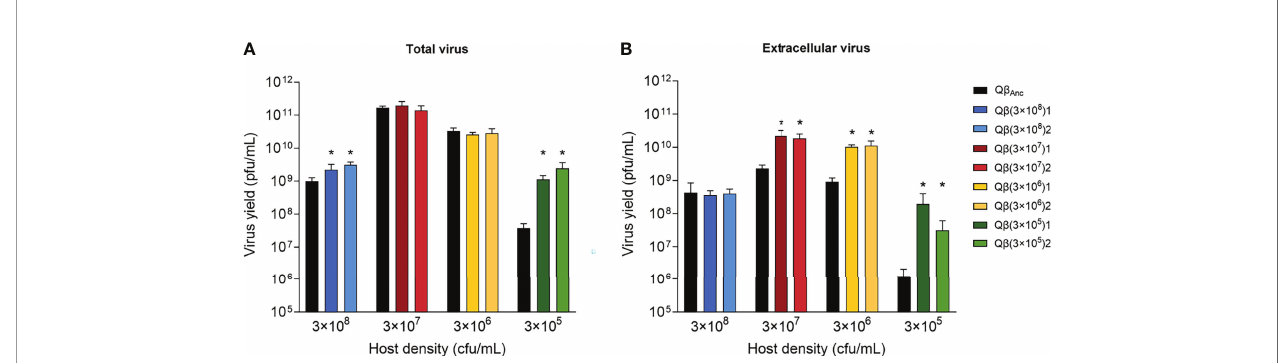
FIGURE 3 | Replicative ability of the lineages obtained at transfer number 16 in comparison with the ancestor. Each evolutionary lineage was assayed at the same bacteria density at which it had evolved (indicated at the bottom of the fi gure). Each bar represents the average of three replicas. The color code used to distinguish the different lineages is the same shown in Figure 1 . The virus Q b Anc , which was assayed at all host densities, is shown in black. (A) Total virus. (B) Extracellular virus. Asterisks above the bars indicate that the result is signi fi cantly different from the value obtained for the virus Q b Anc ( p < 0.05) according to a Mann Whitney test. The absence of asterisk indicates that the value obtained did not signi fi cantly differ from that of the ancestor. The type 1 error for multiple comparisons (two evolutionary lines were compared with the ancestor at each bacterial density tested) was